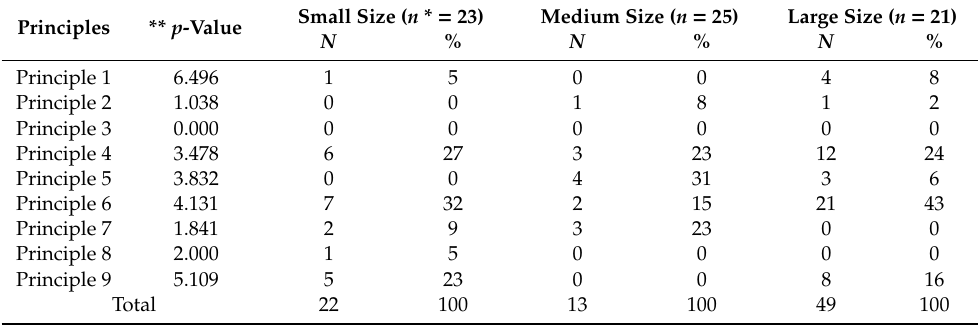
Table 7. The distribution of major non-conformities (NCs) according to the size of leased forest area in 2015 ( n = 69).